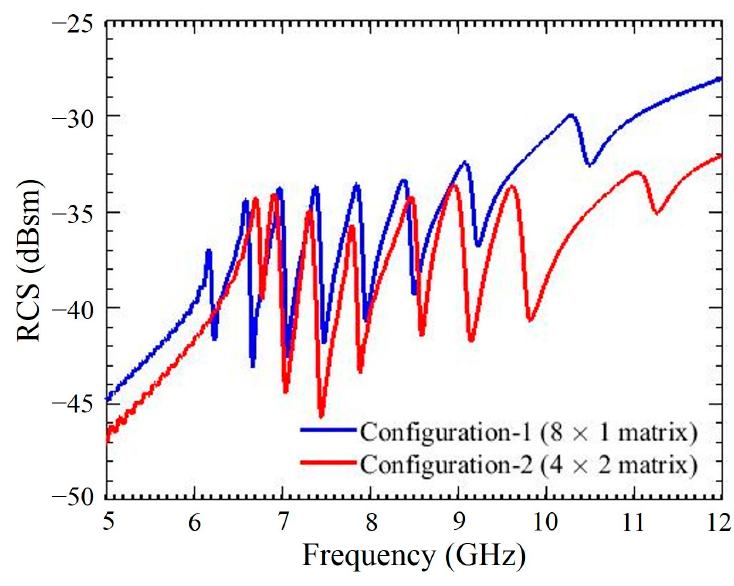
Figure 7. Simulated RCS response of Configuration-1 and Configuration-2.